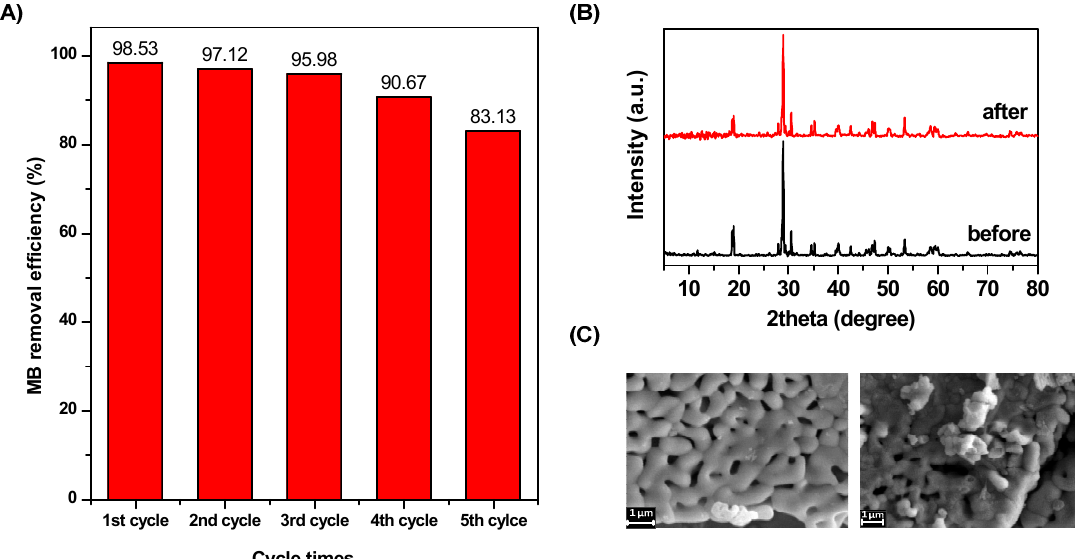
Figure 11. Photo-stability tests over T-BVO-600 sample for the cycling photodegradation of MB ( A ), XRD patterns ( B ), and SEM micrograph ( C ) of T-BVO-600 sample before and after the photo-stability tests.